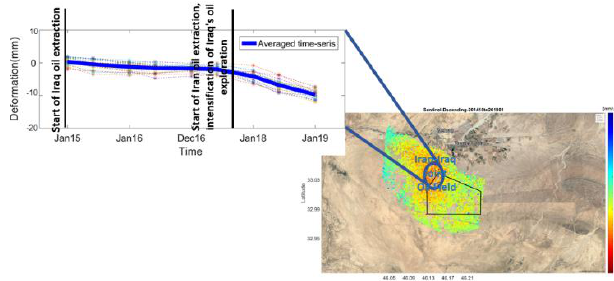
Figure 9. displacement trend for 100 points over time The results, obtained by processing radar images through PSI methods, indicate a 4.5-mm subsidence per year in the line of sight direction. The region’s subsidence is due to oil drilling, considerable precipitations, and the weak soil type. Oil drilling is of paramount importance, and serious measures need to be taken to inspect and control this subsidence. By using specimen from 100 points in the region shown in Figure 9, we modeled this land deformation in Figure 10. R2 of the first line is 0.8948 and for the second line 0.9954. These correlation coefficients represent the good fitting of the line and the accuracy of the fitted model.